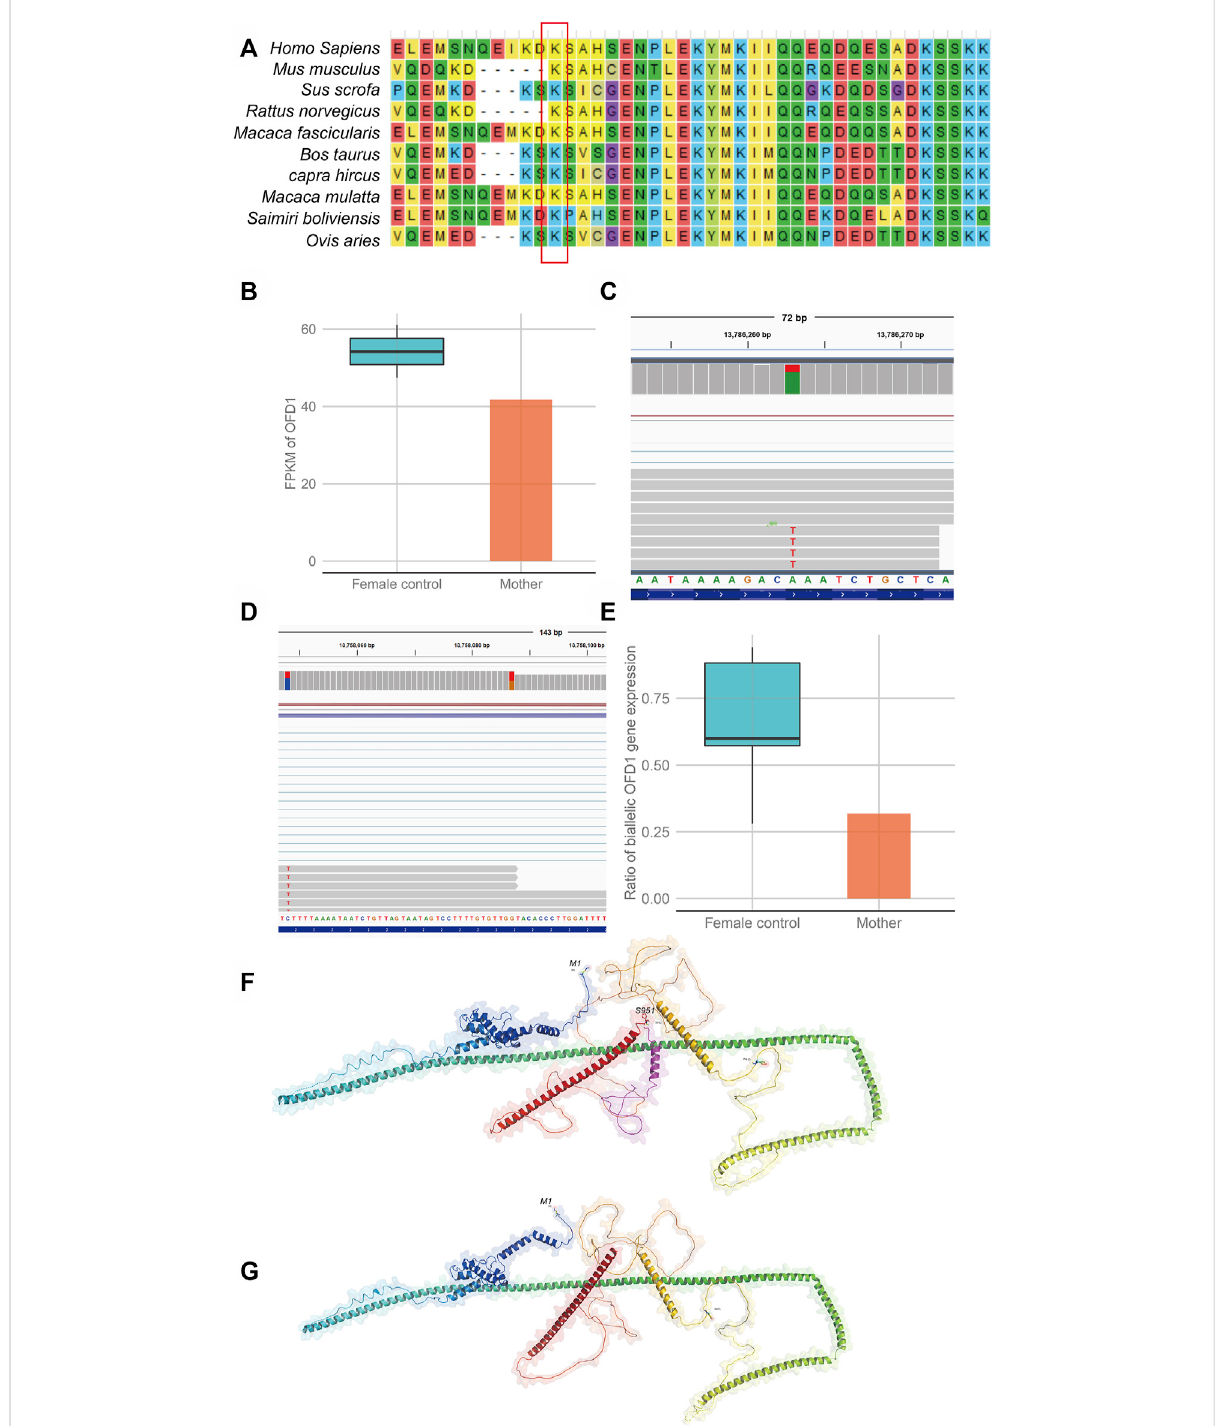
FIGURE 3 Evaluation of the effect of thegene variation on gene function (A) . Alignment of multiple OFD1 protein sequences across species. Letters in the redrectangleshowthattheregionsofthevariantp.Lys950Terwerehighlyconservedacrossdifferentspecies. (B) ComparisonofOFD1expressionin blood between a heterozygous mutant individual (mother) and wild-type female individuals (female controls). (C) Biallelic expression bias of OFD1 occursin themother. (D) Biallelicexpressionbias ofOFD1 occurs inwild-type femaleindividuals (female control). (E) The expression bias ismoreseriousinthemutantindividual(mother). (F,G) Thepredictedstructureofthemutantproteinandwild-typeproteinbyAlphaFoldsoftware. (F) (wild-type protein), the amino acid in the red box is missing from the mutant protein. (G) (mutant